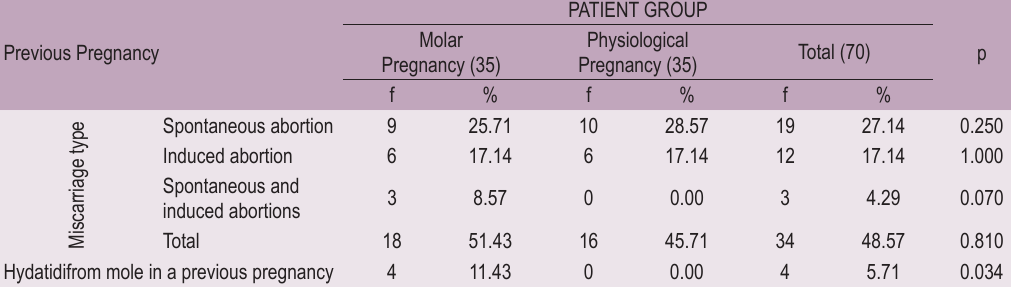
TABLE 3. Number and characteristics of pregnant women according to a type of miscarriage and hydatidiform mole prevalence in a previous